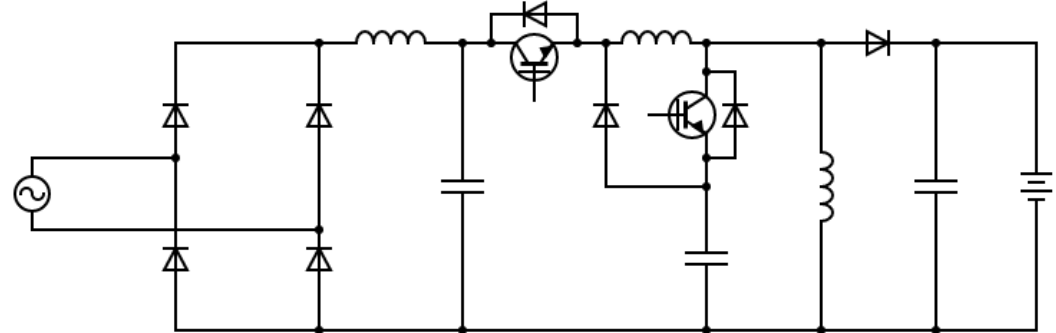
Figure 14. Quadratic buck-boost converter [57].